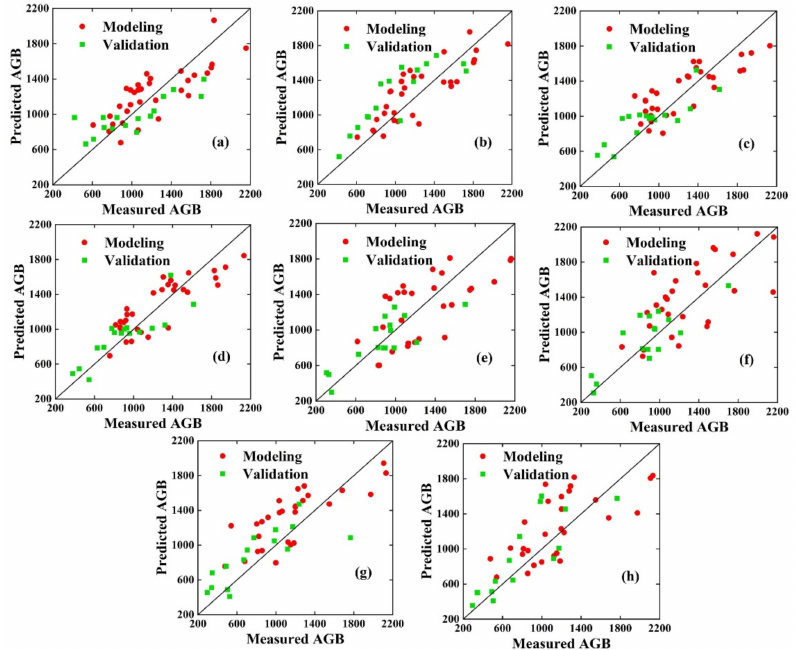
Figure 7. Relationship between measured and RF-estimated potato AGB (kg/hm 2 ) at different growth stages: ( a ) VIs, ( b ) VIs and optimal GEPs (tuber form stage); ( c ) VIs, ( d ) VIs and optimal